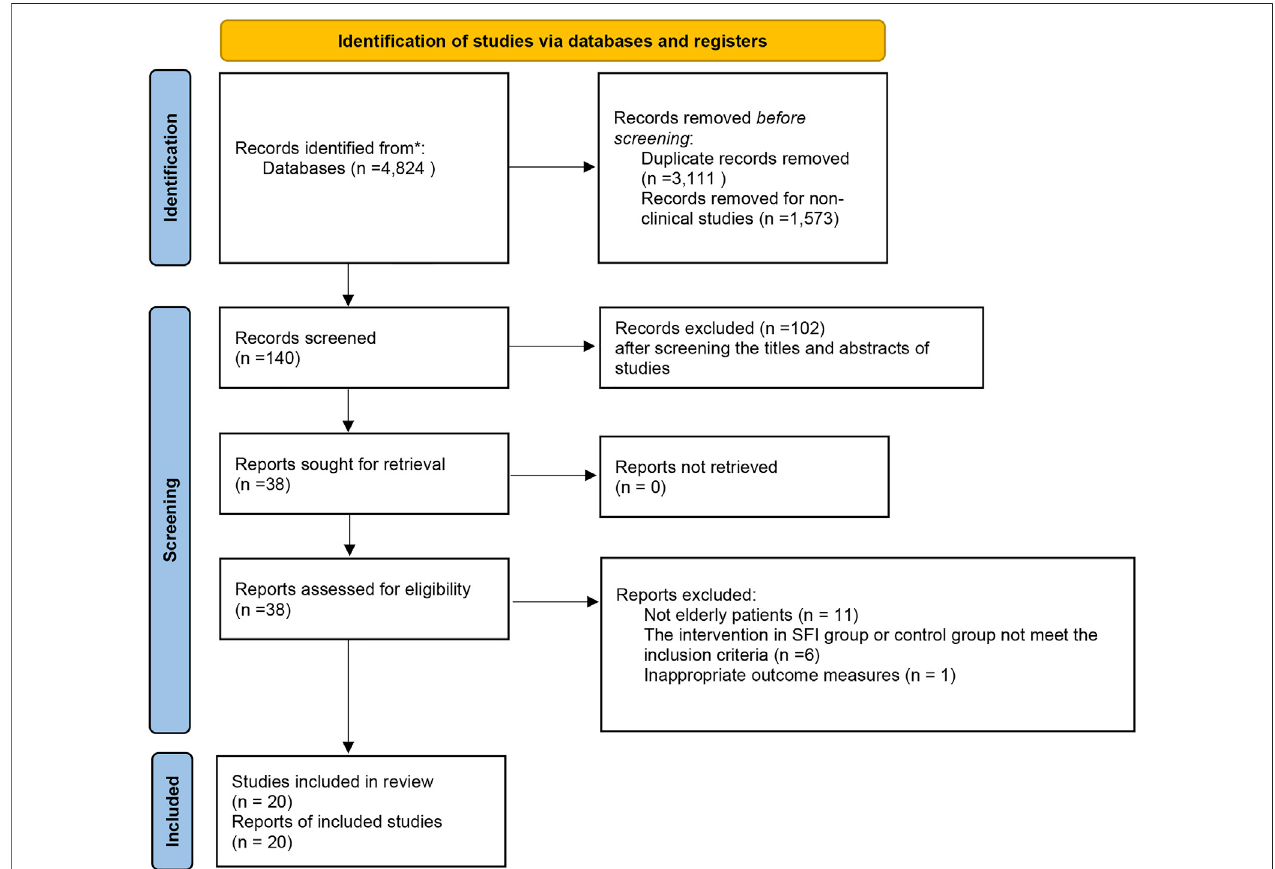
FIGURE 1 | Flow diagram for the process of included study identi fi